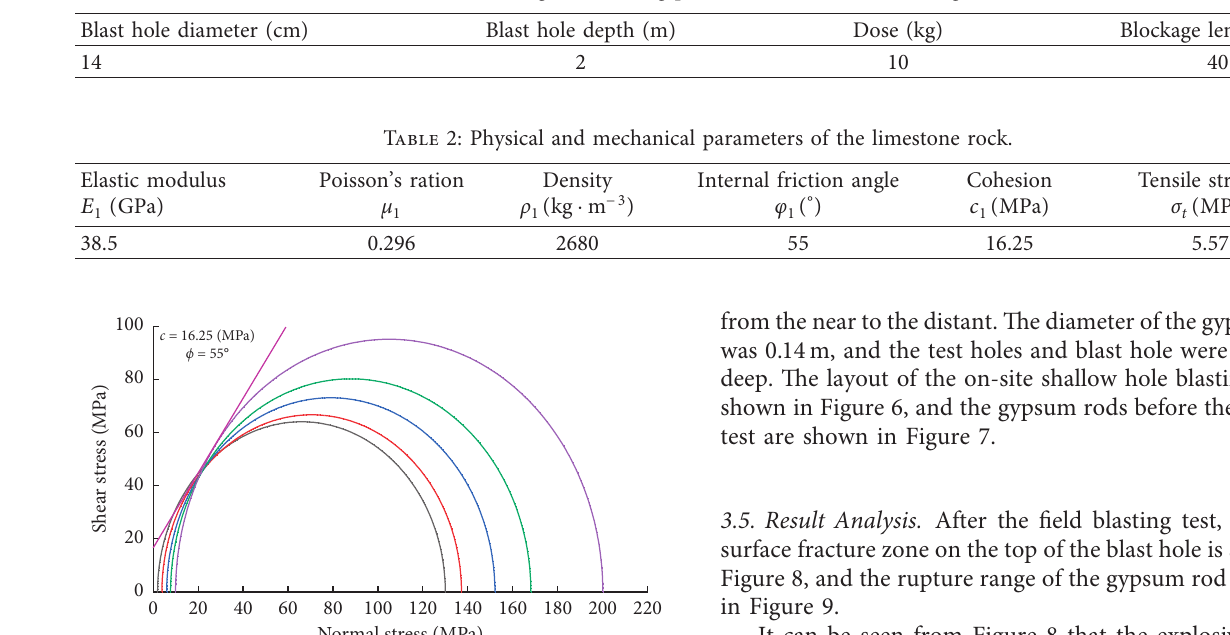
Table 1: Drilling and blasting parameters of the field blasting